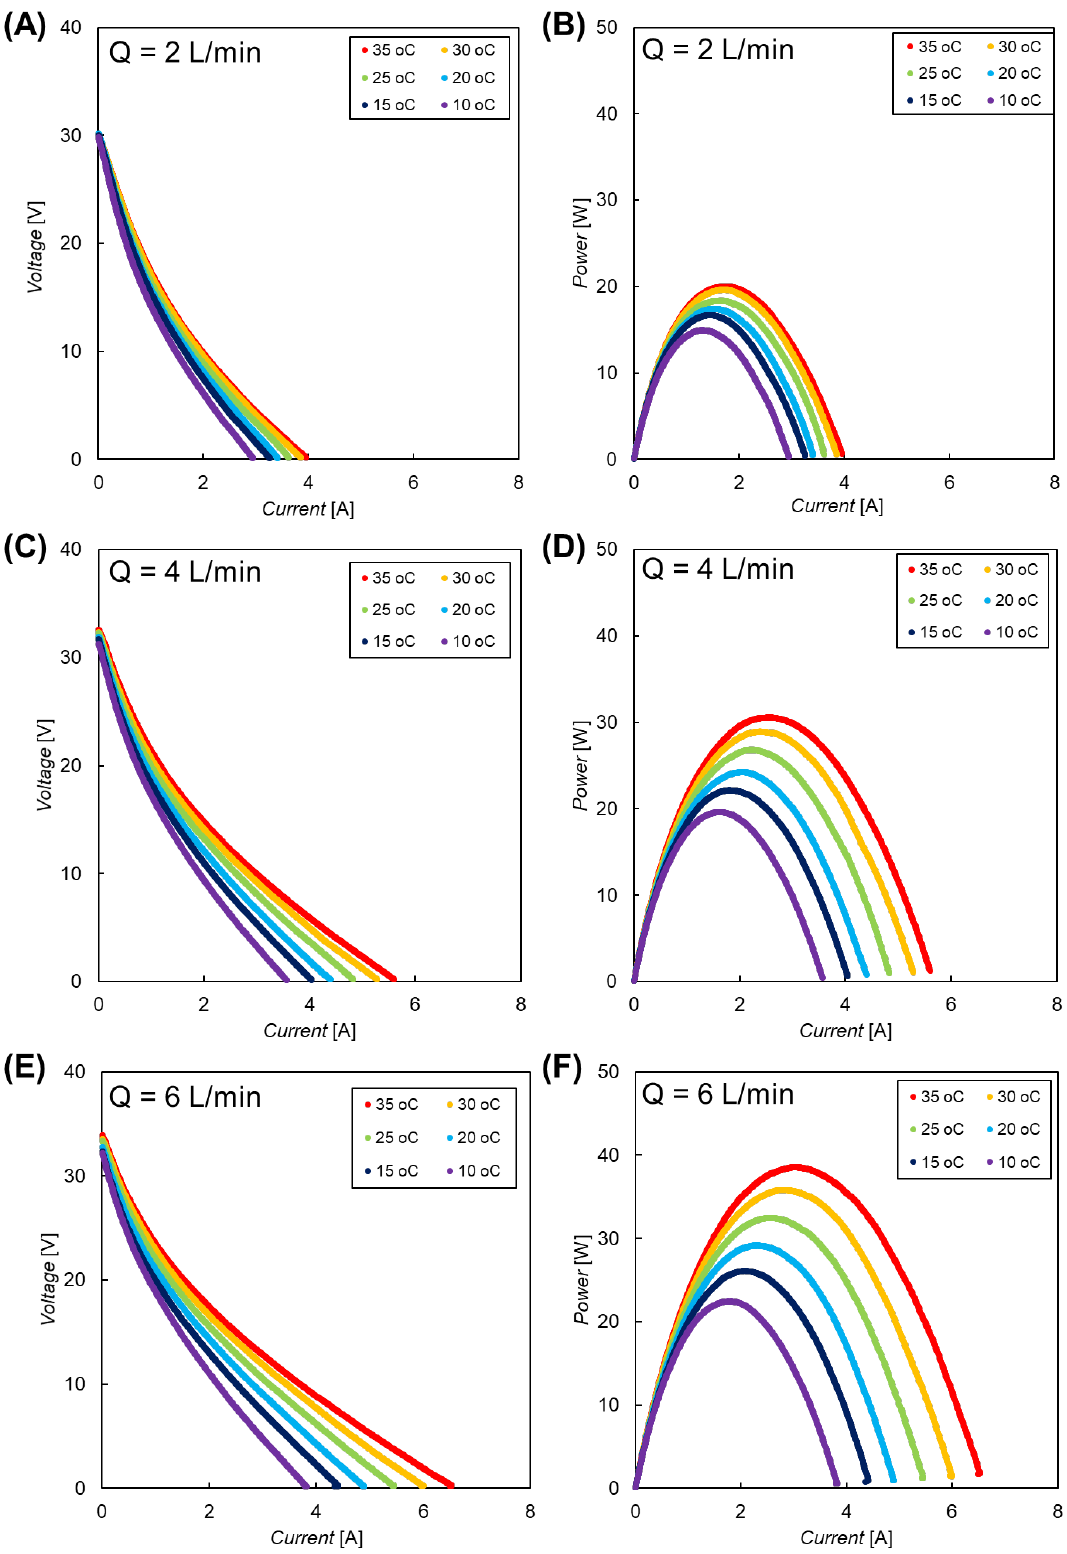
Figure A1. ( A , C , E ) current-voltage (I-V) and ( B , D , F ) current-power (I-P) relationships of the RED stack having the intermediate distance of 200 µm at 10–35 °C with different flow rate, Q.